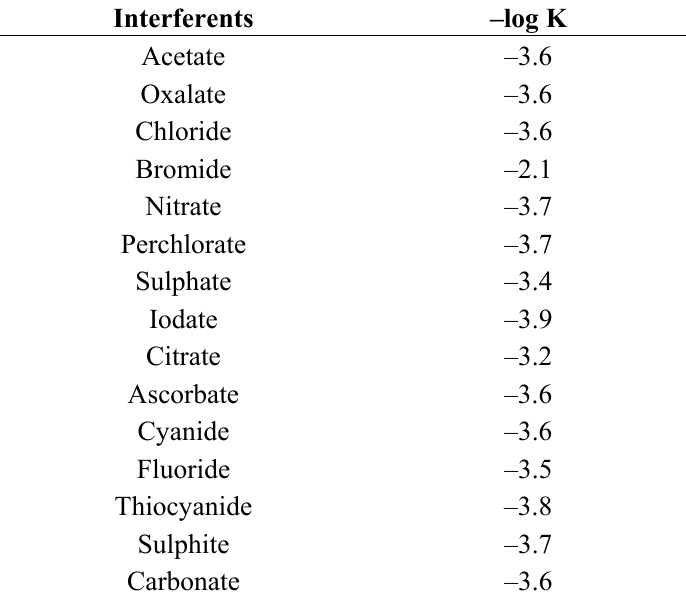
Table 1. The logarithm of selectivity coefficient values.